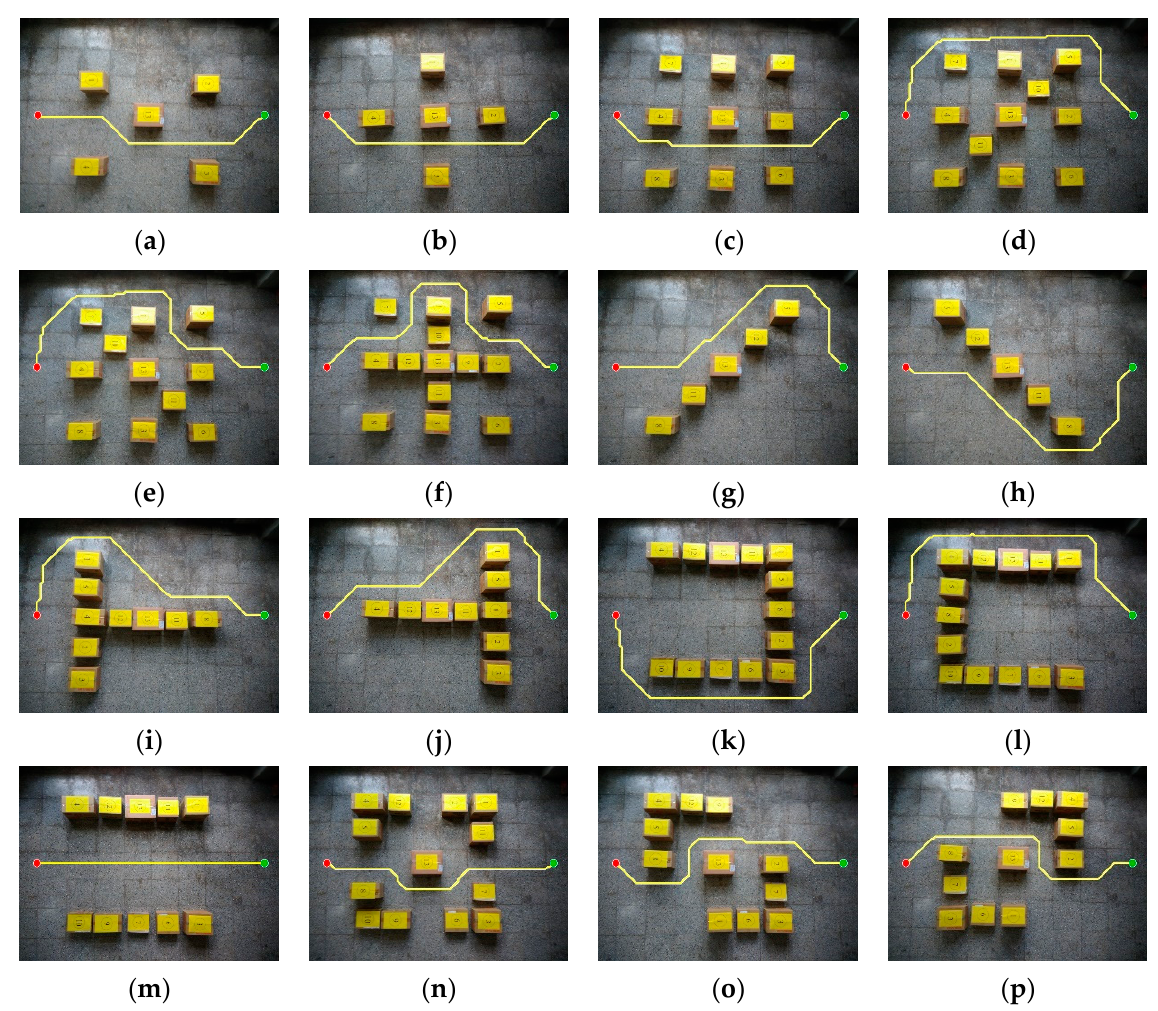
Figure 24. Planned paths shown in Experiment V: ( a ) result #1; ( b ) result #2; ( c ) result #3; ( d ) result